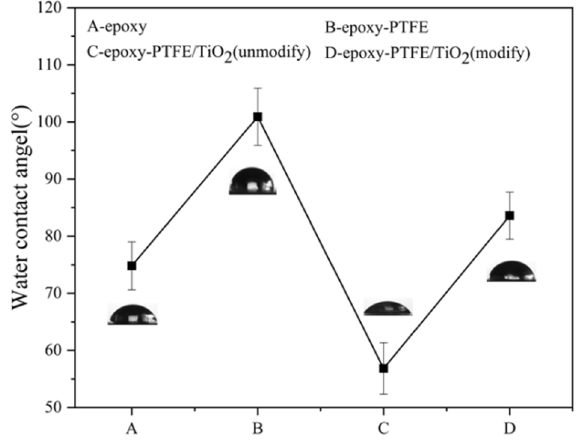
Figure 8. Water contact angles of four kinds of coatings.